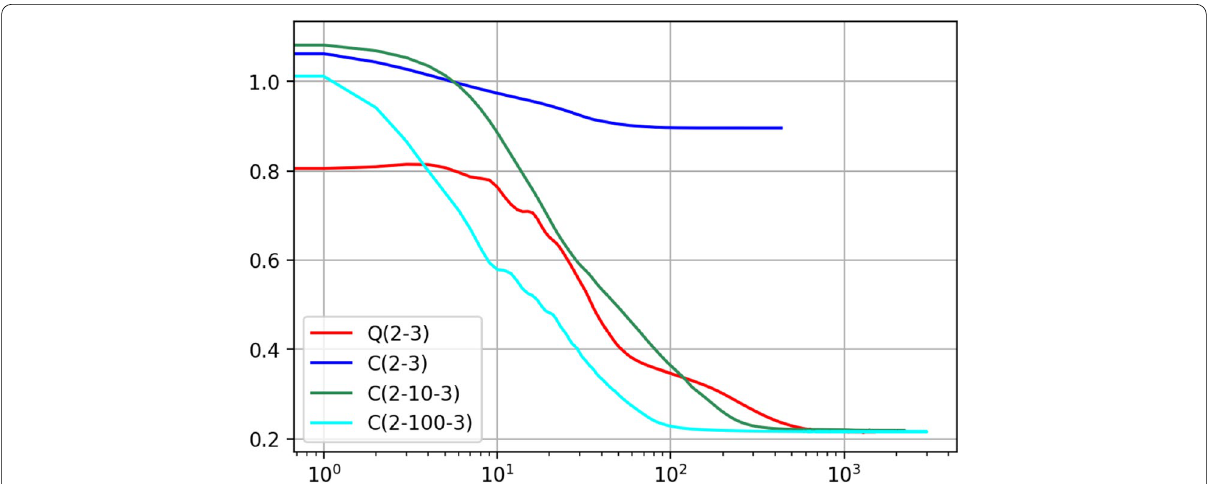
Fig. 6 Decreasing loss on the validation samples during the training process of conventional (C) and quadratic (Q) neural networks with different numbers of neurons. The notation ( · ) stands for the architecture of a neural network as described in Eq.